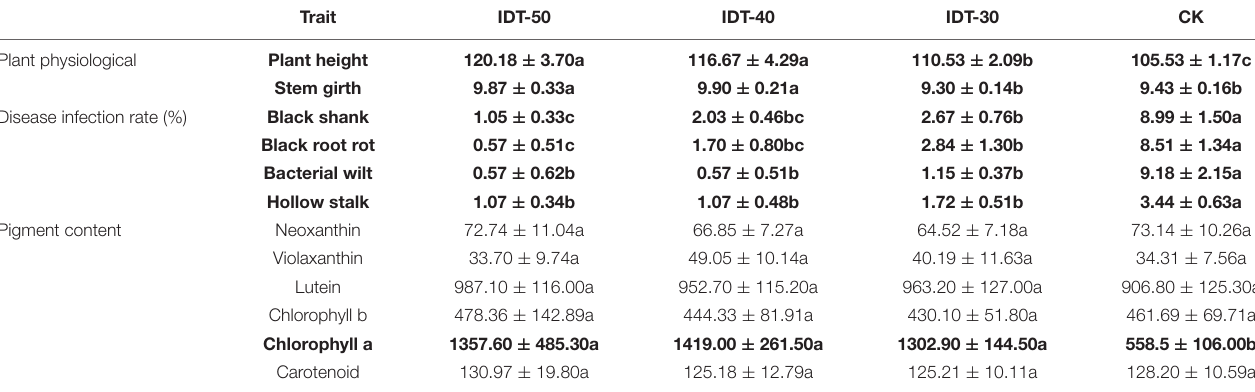
TABLE 5 | Plant performance including plant physiological growth status, disease infection rate, and pigment content respond to different tillage treatments.